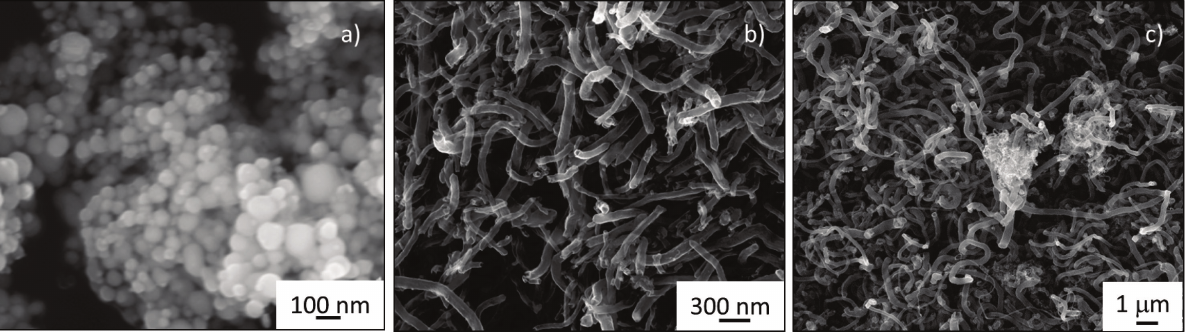
Figure 2. Microstructural Analysis of CNF and WS Scanning Electron Microscopy secondary electron images of ( a ) starting nickel nanoparticles; ( b ) carbon nanofibers grown from Ni catalyst; ( c ) nanoparticle dispersion and cluster of WS nanoparticles within carbon nanofibers (CNF/IF-WS 2